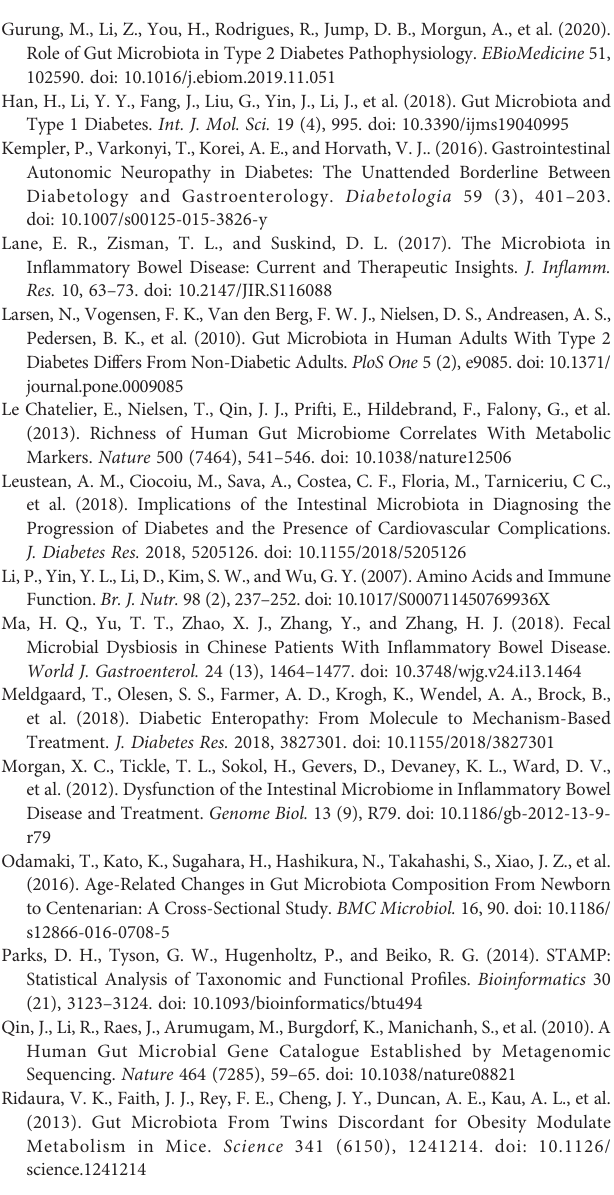
Supplementary Figure 2 | The signi fi cantly and differentially pathway between Normal people and T2DM patients. The left X-axis represents different groups, the Y-axis represents the average relative abundance of a species in different groups, and the right represents the con fi dence interval and p-value. Supplementary Figure 3 | The signi fi cantly and differentially pathway between Normal people and T2DM_GAN patients. The left X-axis represents different groups, the Y-axis represents the average relative abundance of a species in different groups, and the right represents the con fi dence interval and p-value. Supplementary Table 1 | Illumina sequencing summary. Supplementary Table 2 | GAN exacerbates gut microbiota dysbiosis in adult patients with T2DM. Notes: Kruskal-Wallis Test is used to compare the three groups (Normal vs T2DM vs T2DM_GAN group, kruskal pvalue). And multiple comparisons are performed using Wilcoxon Signed Rank Test and corrected using